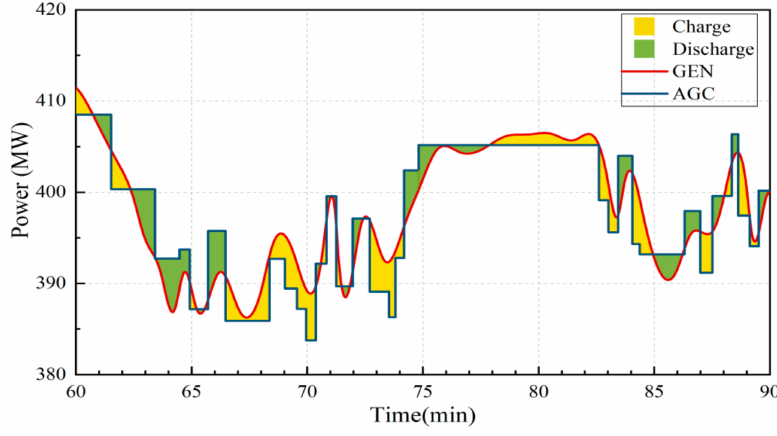
Figure 2. The energy storage system (ESS) participates in AGC ancillary